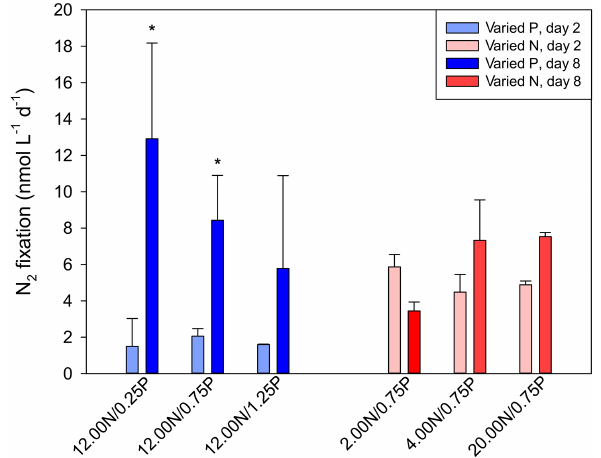
Figure 7. Mean N 2 fixation rates measured on day 2 and day 8 of both experiments. Because of the high variance between repli- cates we omitted N 2 fixation rates from un-replicated treatments. Asterisks indicate a significant difference between day 2 and day 8 ( t test). Error bars indicate the standard deviation.